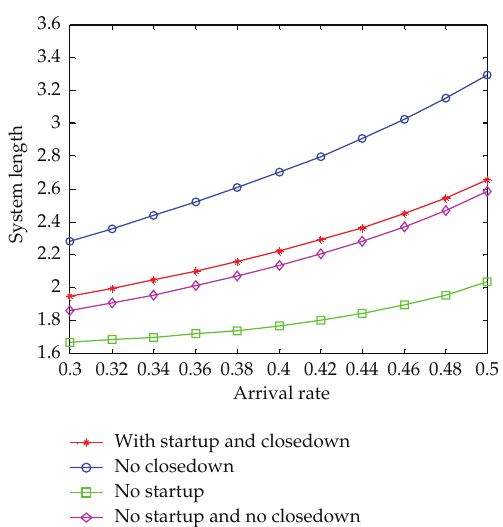
Figure 5: Plot of mean length in the system versus arrival rate with N ∼ Du (cid:3) 1 , 5 (cid:4) , S ∼ Geo (cid:3) 0 . 4 (cid:4) , B ∼ Geo (cid:3) 0 . 7 (cid:4) , and C ∼ Geo (cid:3) 0 . 5 (cid:4) , the values of arrival rate λ varying from 0.3 to 0.5 by the increment 0.02.